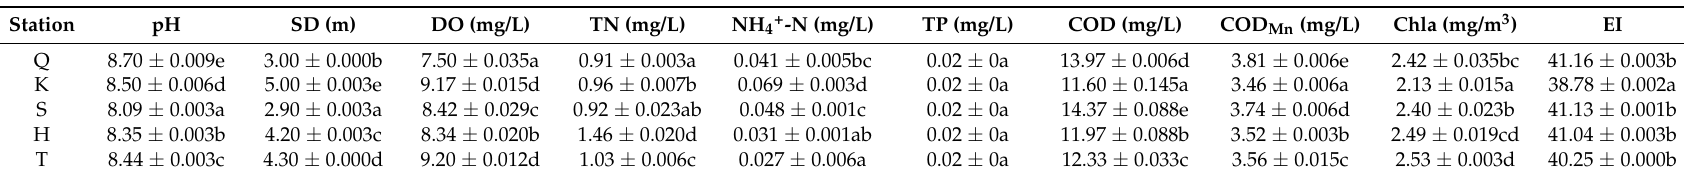
Table 1. Main physico-chemical characteristics of water samples. Station codes represented the first letter of their names: Q: Qushou, K: Kuxin, S: Songgan, H: Heijizuo, T: